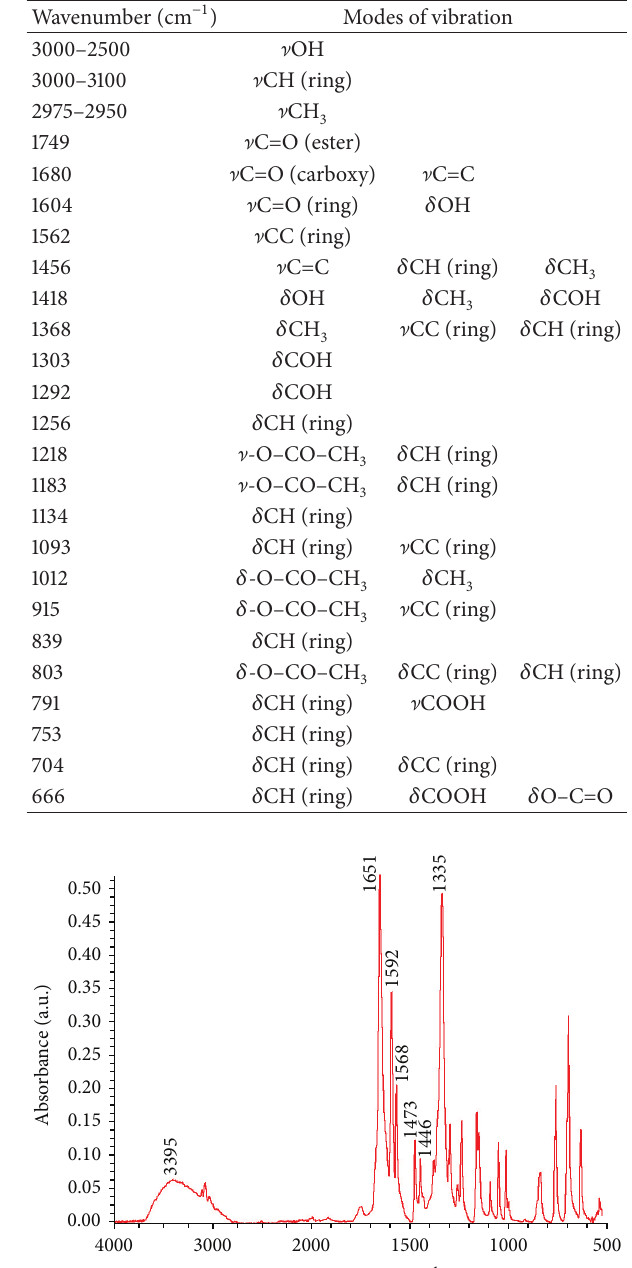
Table 1: Observed vibrational modes for picolinic acid [28–34]. Wavenumber (cm −1 )